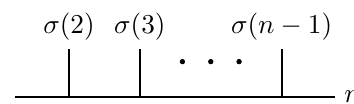
Figure 1 . The basis graphs for any tree-level kinematics that satisfy Jacobi-like relations can be expressed in terms of half-ladder diagrams where two legs, say 1 and n , are held fixed, and all other leg labels σ ( i ) are permuted. See, e.g., ref. [31] for the relevant argument applied to color-factors. re-express the color dressings in a minimal color basis of ( m − 2)! color weights [31],